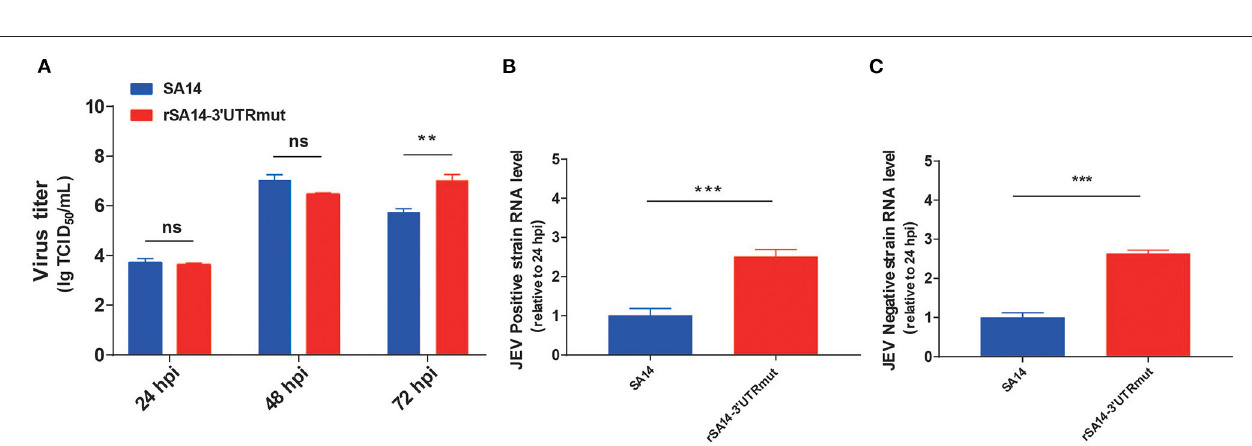
FIGURE 2 | The prediction of RNA secondary structures in 3 ′ UTR SL-IV and DB1 structure regions. The RNA secondary structures with the location of 3 ′ UTR differences between JEV strains SA14 (A) and rSA14-3 ′ UTRmut (B) . RNA structure was used to predict the RNAfold (http://rna.tbi.univie.ac.at//cgi-bin/ RNAWebSuite/RNAfold.cgi) in the mutated regions.